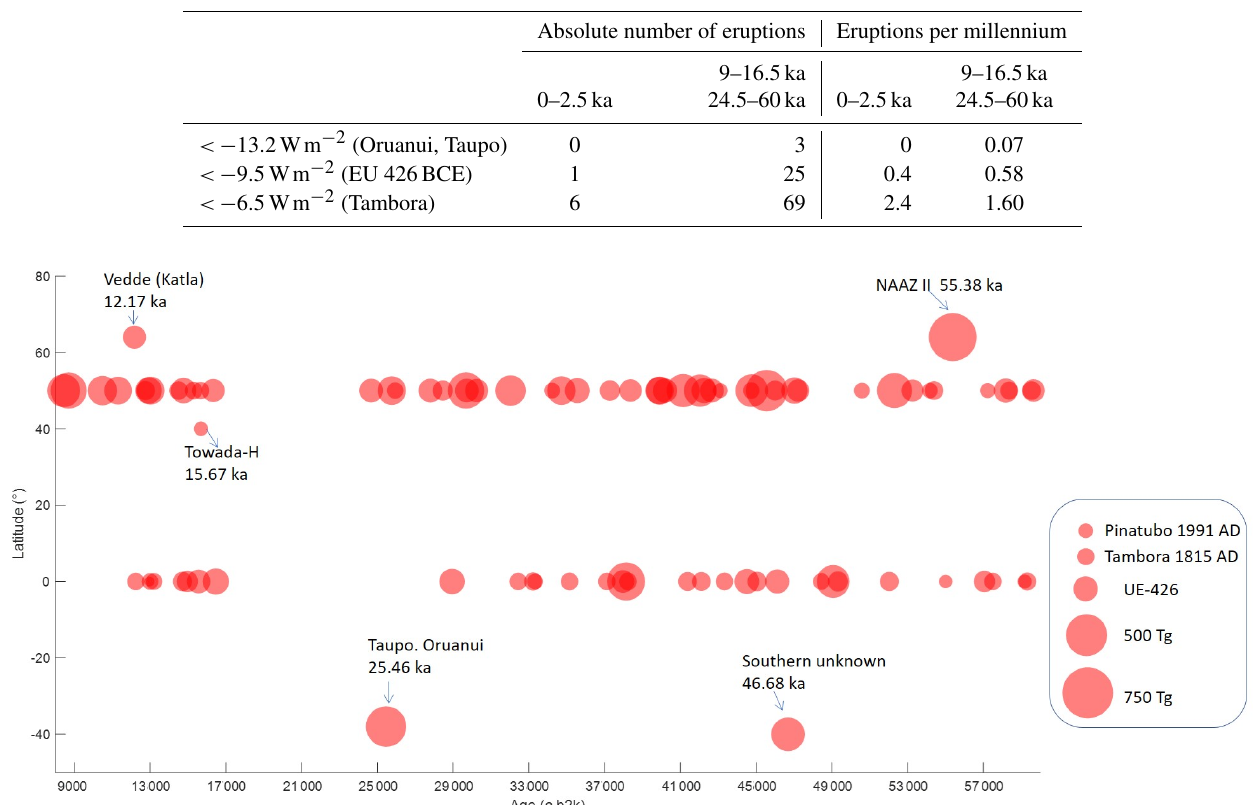
Figure 6. Schematic of the latitudinal location for the identified bipolar volcanic eruptions (Table S5). Volcanoes for which the eruption site is predicted above 40 ◦ N are marked at 50 ◦ N, and those predicted below 40 ◦ N are marked at the Equator. Volcanic locations that are known from ice-core tephra deposits are indicated by name and age of the eruption (Table S5). Due to its high relative sulfate deposition in Antarctica, the eruption at 46.68ka, marked at 40 ◦ S in the figure, is very likely from the Southern Hemisphere, but the eruption site is unknown. The size of the circles represents the strength of volcanic stratospheric aerosol